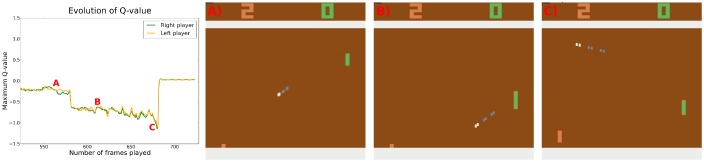
Cooperative game—game situations and the Q-values predicted by the agents.A) The ball is moving slowly and the future reward expectation is not very low—the agents do not expect to miss the slow balls. B) The ball is moving faster and the reward expectation is much more negative—the agents expect to miss the ball in the near future. C) The ball is inevitably going out of play. Both agents’ reward expectations drop accordingly. See supporting information for videos illustrating other game situations and the corresponding agents’ Q-values.